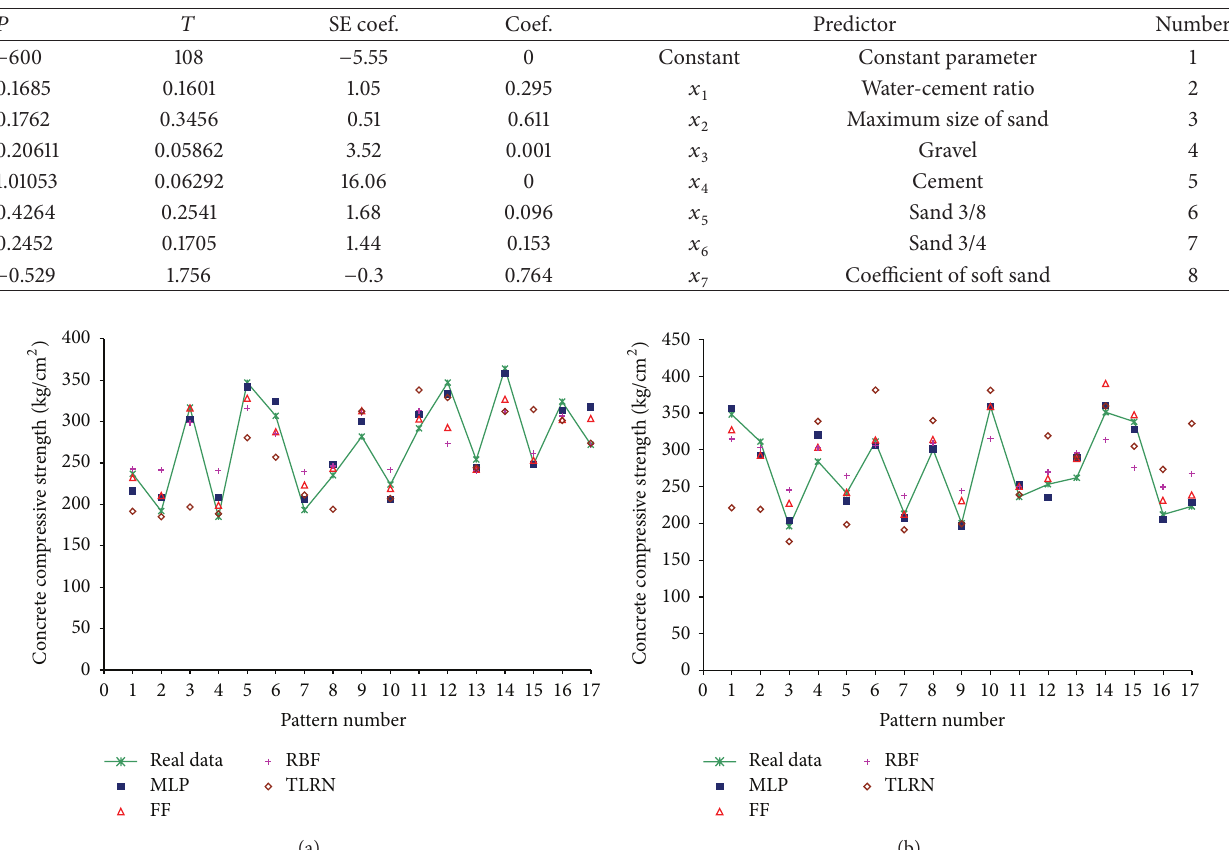
0.000.400.801.201.602.00